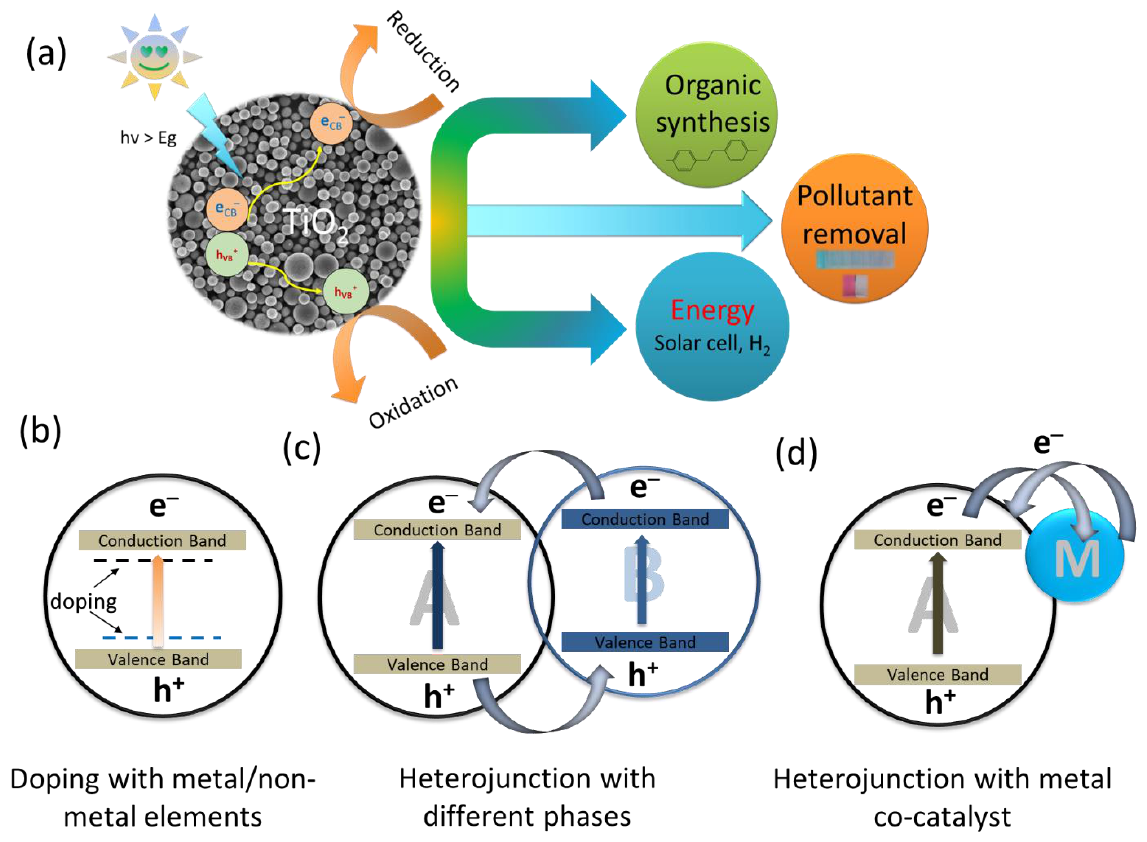
Figure 1. ( a ) Photocatalytic reaction by TiO 2 and their applications; ( b ) doping effects; ( c ) hetero- junction with other semiconductors or phases; ( d ) heterojunction with metal